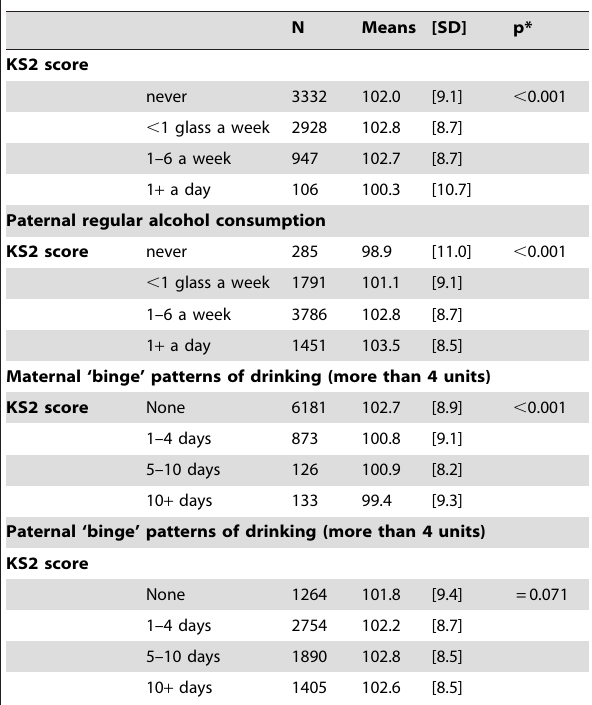
Table 3. Univariable associations between KS2 scores and potential confounding factors [means (SD)] at age 11 (complete case analysis,